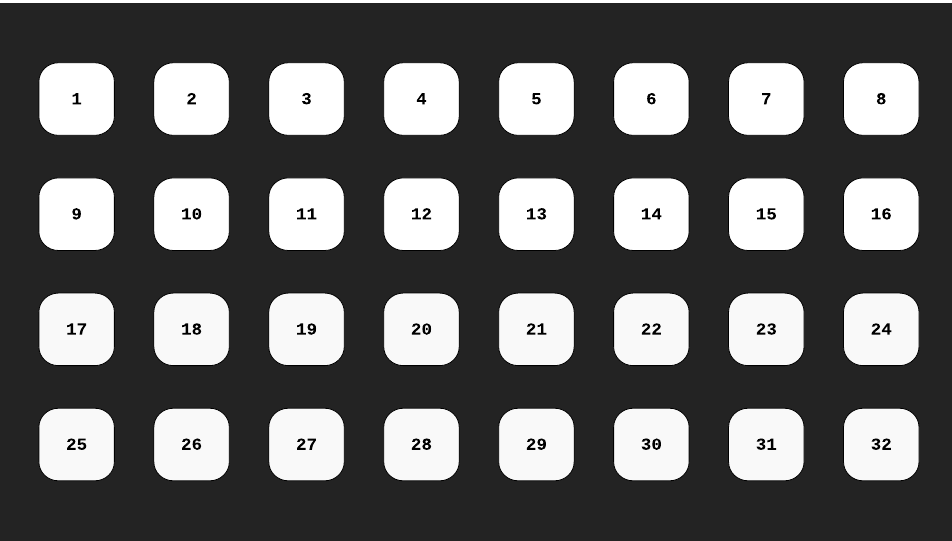
Figure 1. The graphical user interface (GUI) used in the training phase of online experiment [15] with 32 targets. During the training session, the current target on which the participants needed to fix their gaze was marked with a green